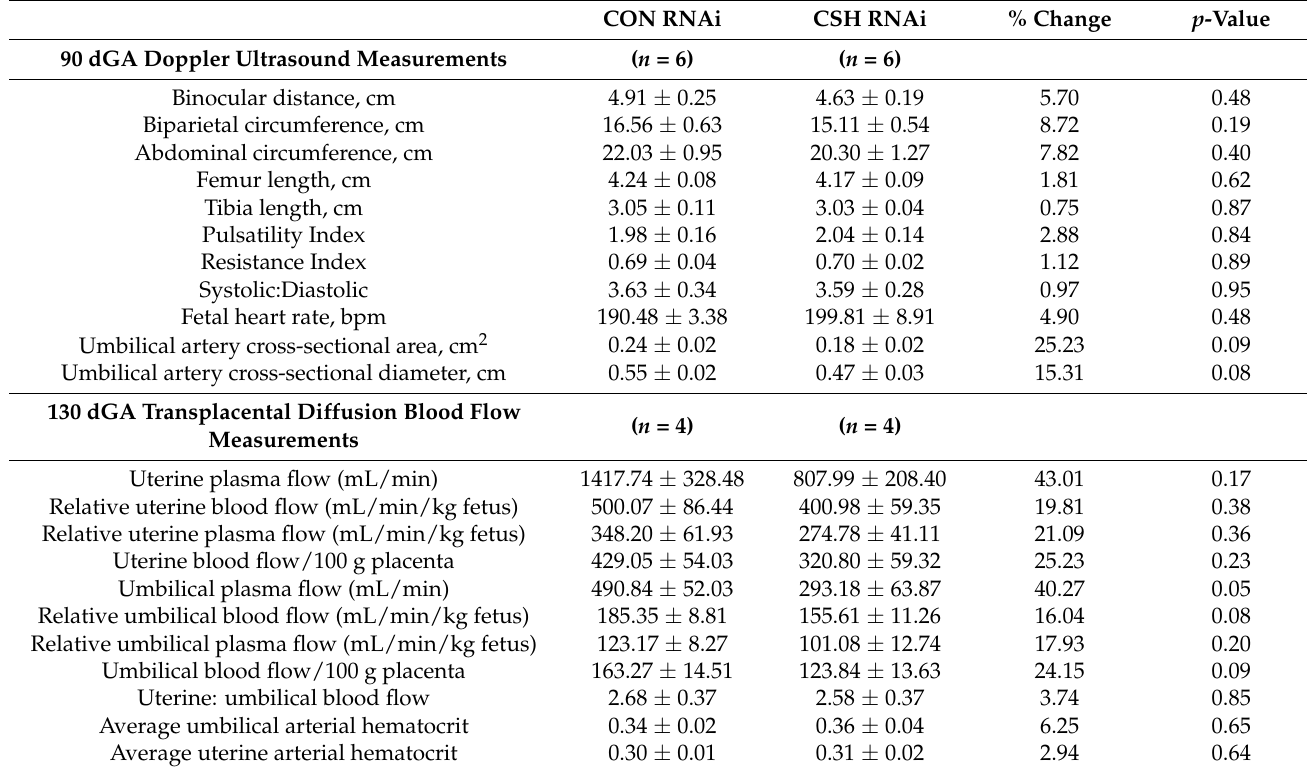
Table 2. Measures of blood flow and fetal growth as assessed by 90 dGA Doppler velocimetry and 130 dGA 3 H 2 0 transplacental diffusion. CON RNAi CSH